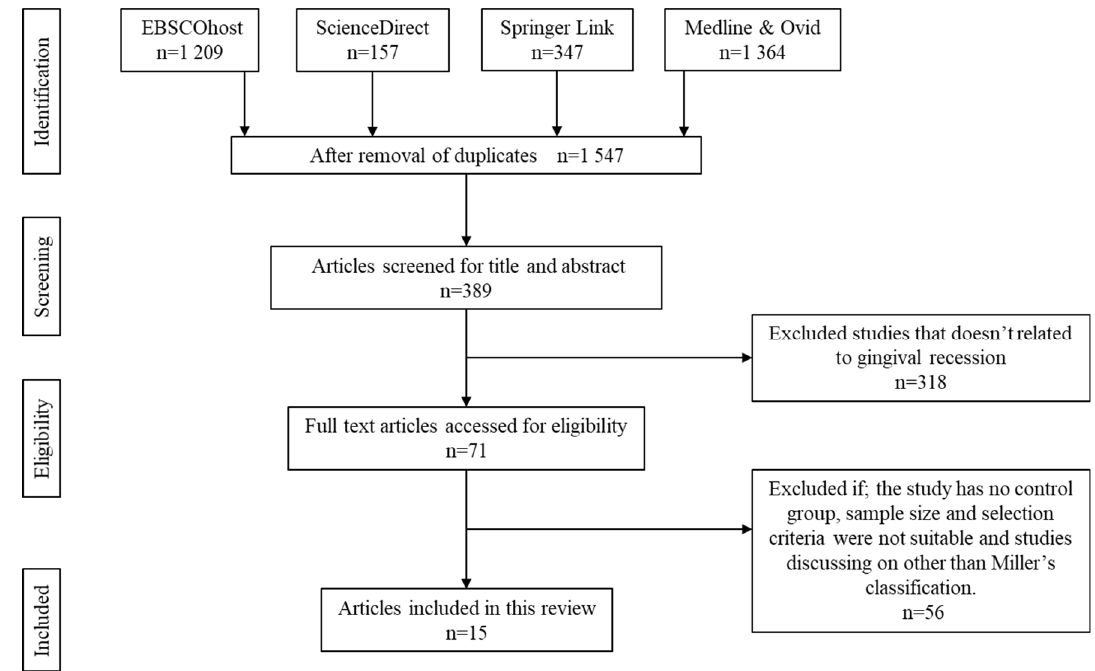
Figure 5. Identification and screening for literature search.